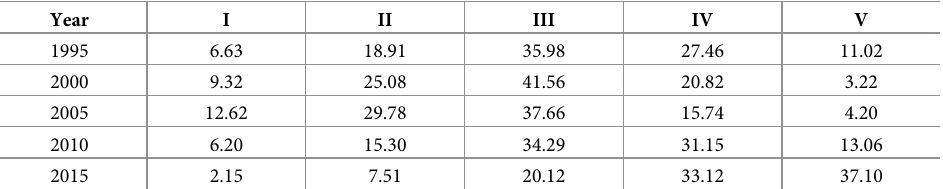
Table 3. Proportions of ecological security levels in CYP at the pixel level